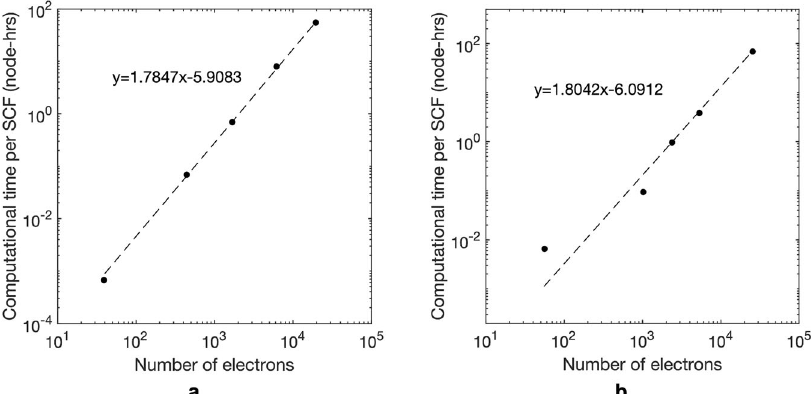
Fig. 5 Computational complexity of the tensor-structured approach. a Aluminum nano-particles Oð N 1 : 78 Þ Oð N 1 : 8 e